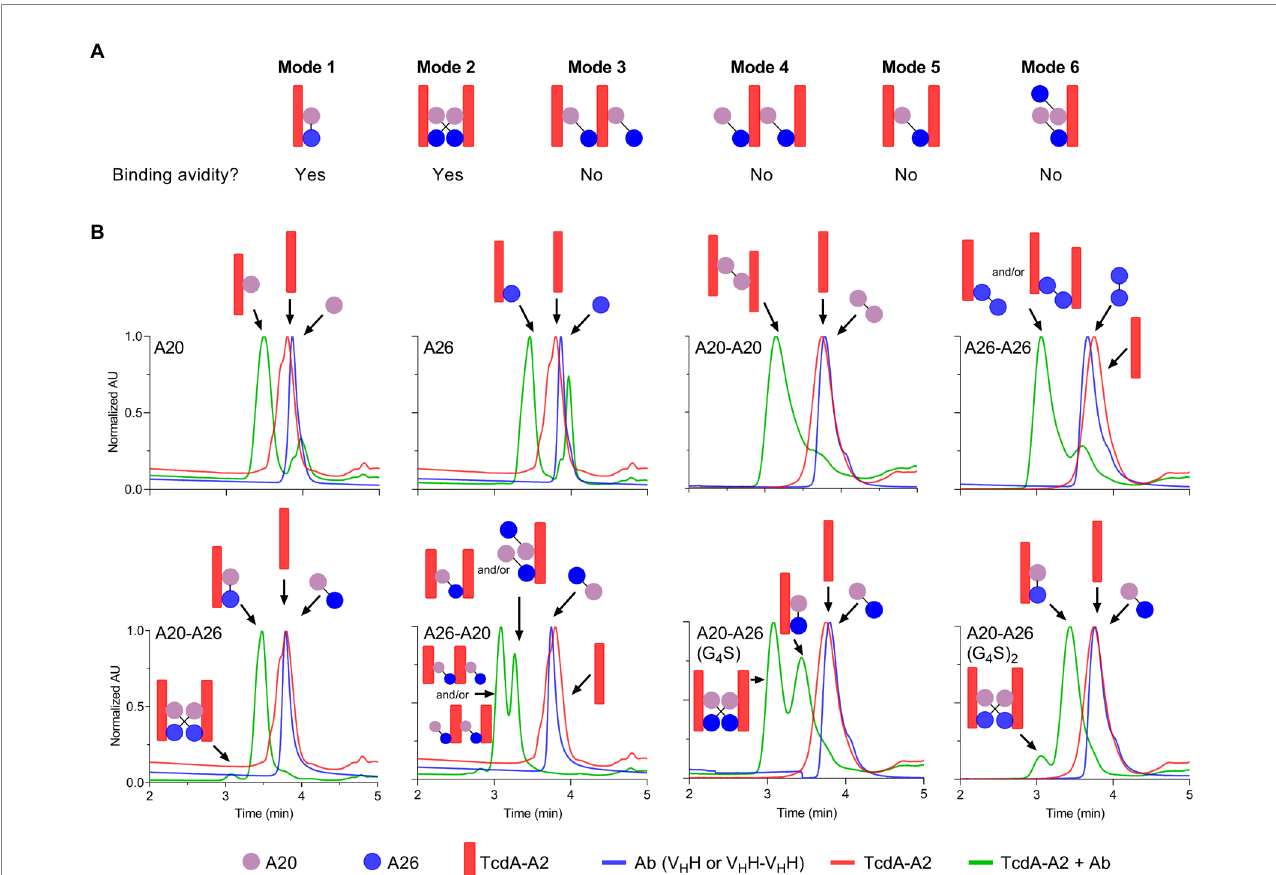
FIGURE 4 Binding modes and UPLC-SEC chromatograms of TcdA-A2-V H H complexes. (A) Binding modes for the interaction of TcdA-A2 and heterodimeric V H Hs in solution were determined based on molecular mass ( M obs ), retention time ( T r ) and TcdA neutralization data. (B) Chromatograms are shown for TcdA-A2 (red lines), the various antibodies (blue lines) and the 1:1 molar mixture of the two proteins (green lines). The M obs s of the peak in each chromatogram was estimated from MALS UV. Schematic representations of TcdA-A2, V H H or V H H-V H H and complexes of the two proteins are shown for each peak. AU, absorbance